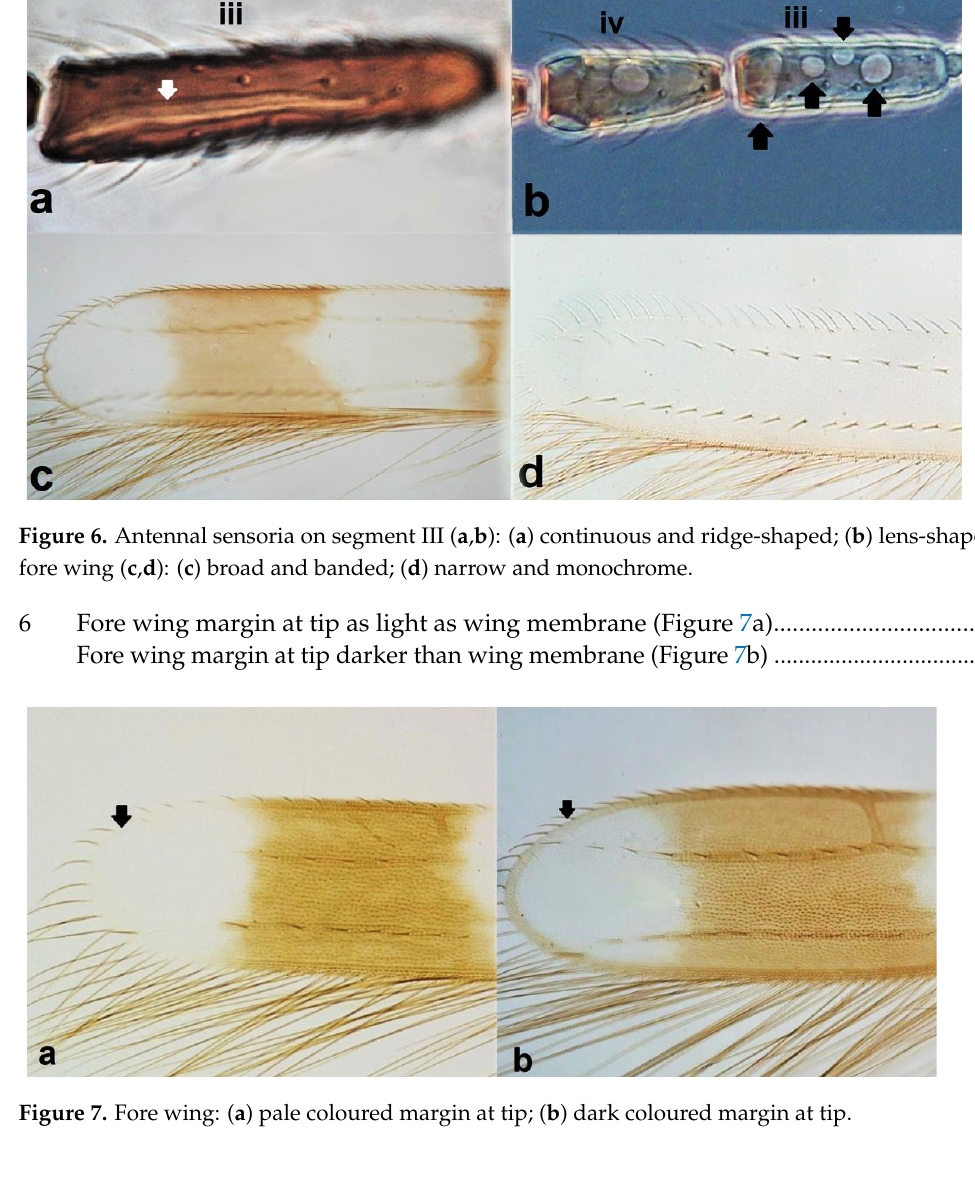
7 Body bicoloured, with head and thorax yellow with brown areas medially (Figure 8a); antennal segment III bicoloured, with the basal half of segment pale yellow, while the apical half dark brown (Figure 8c) …………………….. Aeolothrips gloriosus Bagnall Body uniformly dark brown, though upper abdominal segments can sometimes be lighter coloured (Figure 8b); antennal segment III yellow or yellowish brown with the distal fifth brown, paler than segment II (Figure 8d) .. Aeolothrips intermedius Bagnall